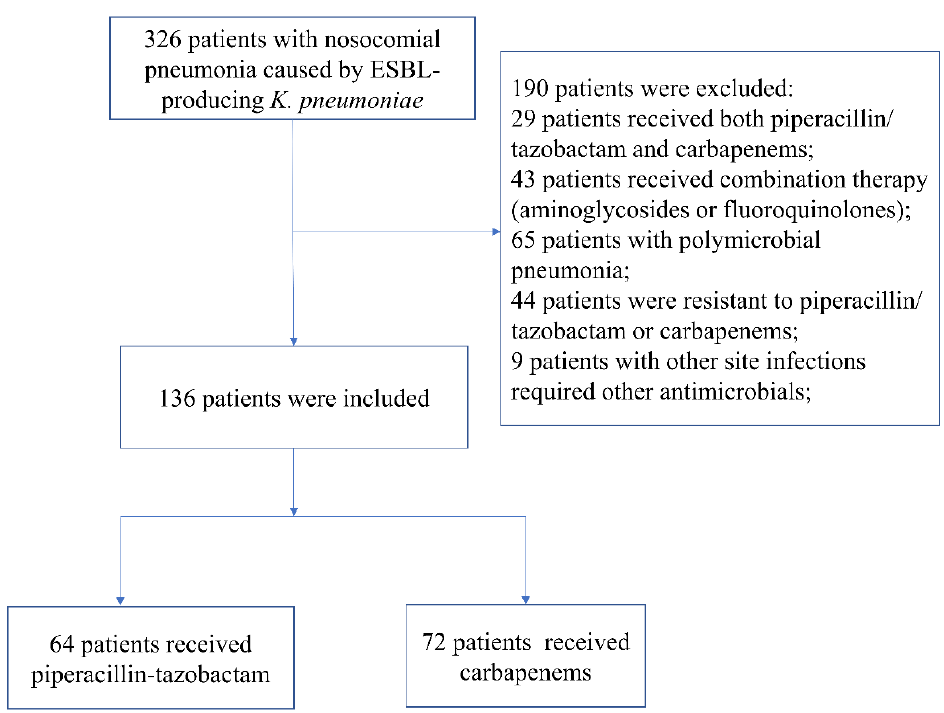
Figure 1. Flowchart of the study inclusion process.